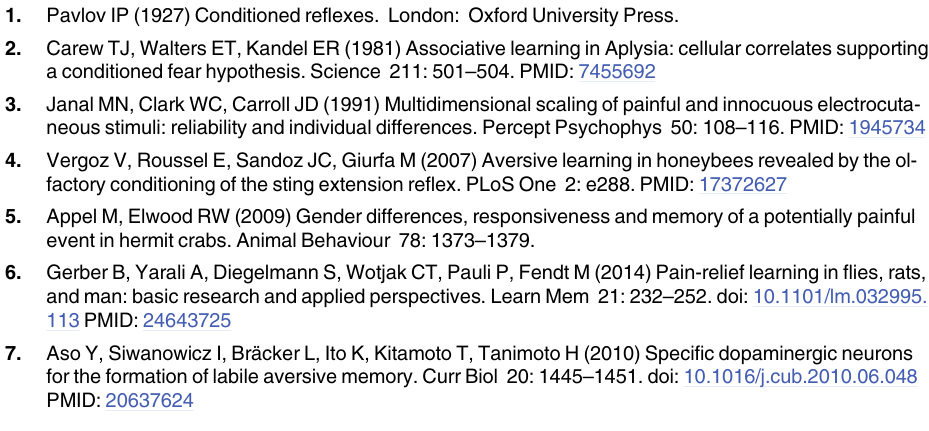
S6 Table. Network genes. By superimposing the results of our gene expression level — shock avoidance analyses on the existing protein-protein interaction network, we obtained a shock avoidance-relevant network of 38 genes, which are listed along with the statistics of their asso- ciation with shock avoidance (see the legend of S1 Table for details), as well as their relevance for bristles. S7 Table. Independent validation of candidate genes. For 14 candidate genes from S4 Table, we compared appropriate transposon insertion mutants to controls in terms of shock avoid- ance and the level of the respective mRNAs as measured by real-time quantitative RT-PCR. For 7 of these genes, locomotion assays were also run. Here, the results of these analyses are documented in